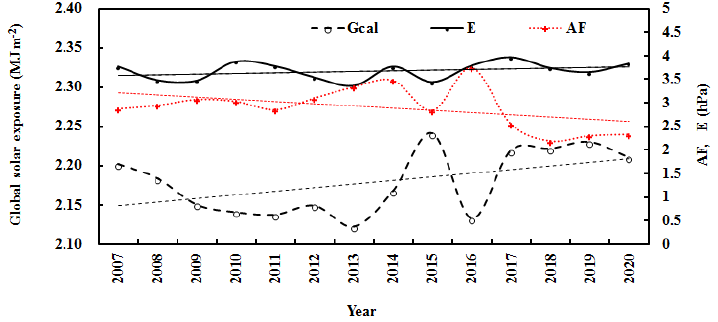
Figure 6. Annual calculated global solar exposures (G cal ), water-vapor pressure (E), and attenuation factor (AF) at the Qomolangma site during 2007–2020. The lines are linear fits to the data for E (upper line), AF (middle line), and G cal (lower line).